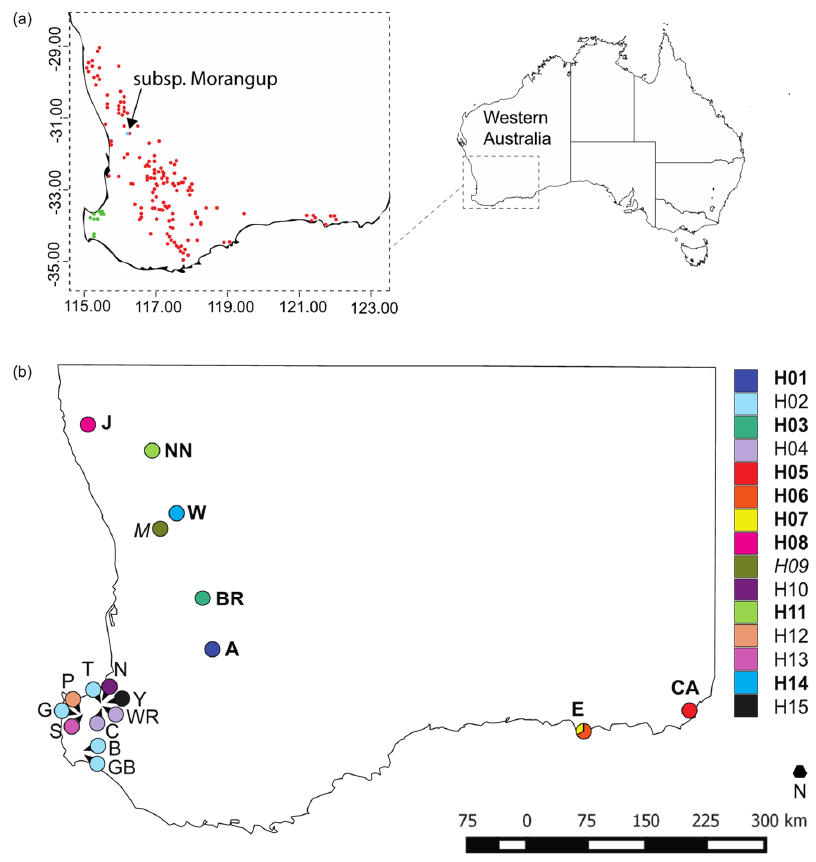
Figure 1. Map showing: ( a ) the distribution of Banksia nivea in southwestern Australia. Dots indicate the locations of known populations based on records of the Atlas of Living Australia [30]. Subspecies indicated by color; red, subsp. nivea ; green, subsp. uliginosa ; blue, subsp. Morangup. ( b ) Distribution of cpDNA ( psb A- trn H, ndhF, trnV, and trn Q- rps 16) haplotypes overlaid on a geographical map of sampling sites. Pie charts show the proportion of sampled individuals with a given